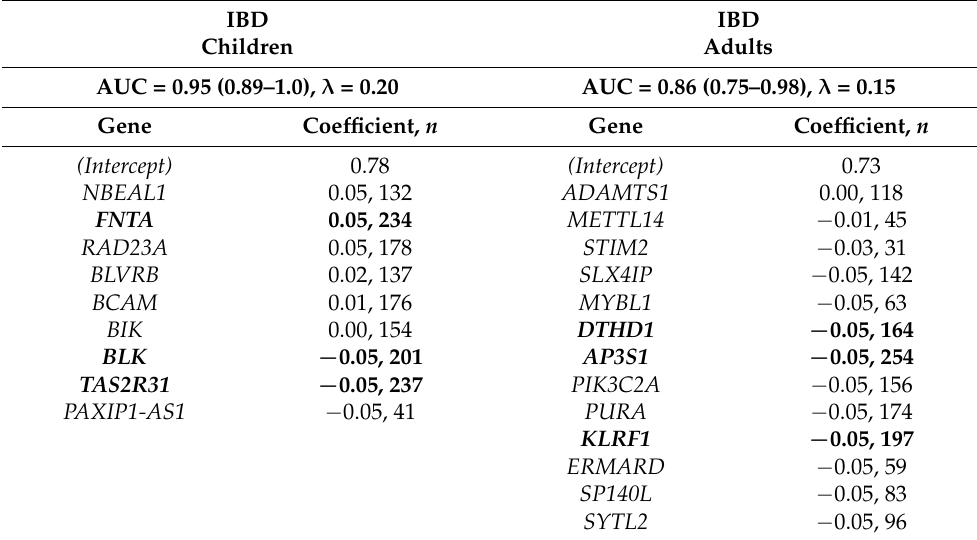
Table 3. Genes were selected by lasso regression to best identify IBD in children and adults (adult patients presented a more quiescent disease relative to children). Coefficients are presented to- gether with the number of times the given transcript appeared in all tested model across the cross- validation/lambda grid (greater values indicate transcripts more systematically linked to IBD). The top three genes (highest n ) are indicated in bold. The area under the curve (AUC; 90% confidence interval), lambda shrinkage parameter, and the intercept for each model are also presented. Please note that the genes with the most discriminatory power are present at the top and the bottom of the list.